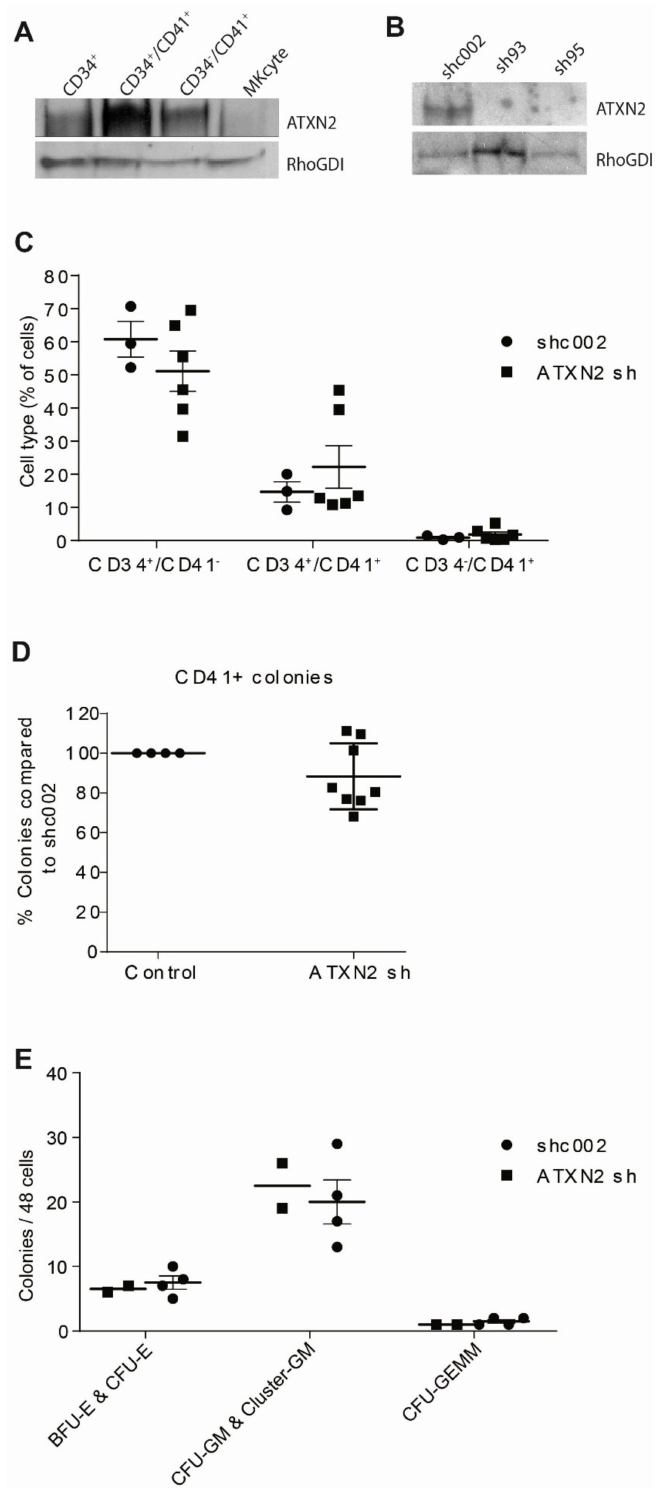
Figure 1. ATXN2 expression during megakaryopoiesis ( A ) Western Blots containing lysates of cells that represent di ff erent stages of megakaryopoiesis were stained for ATXN2 and RhoGDI (loading control). CD34 + : uncultured cells, CD34 + / CD41 - and CD34 + / CD41 + : sorted from day 7 MKs di ff erentiation cultures, and CD34 - / CD41 + : harvested after an additional 7-day culture. ( B ) CD34 + cells were transduced with lentiviral vectors expressing green fluorescent protein (GFP) and shRNA directed against ATXN2 (sh93 or sh95) or control shRNA (sh002). GFP positive cells were sorted 48hours after transduction and cultured for three days. ATXN2 and RhoGDI expression was analysed in total cell lysates. ( C ) CD34 + cells, were transduced with shc002 (control shRNA), sh93, or sh95 (taken